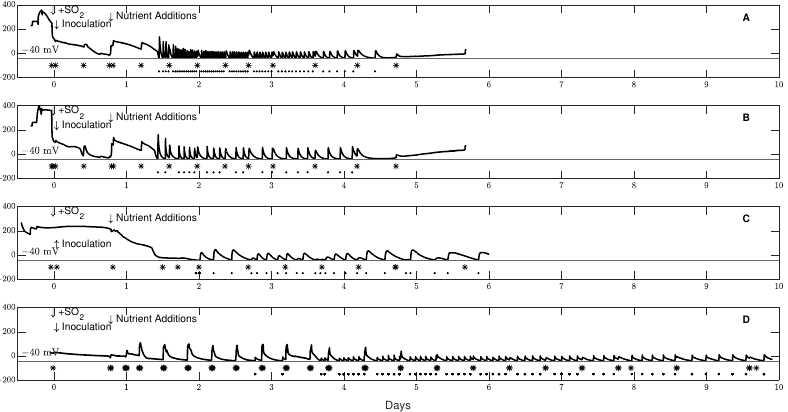
Figure 6. Controlled to –40 mV redox fermentations at scales of 100 L ( A , B ), 1500 L ( C ) and 10,000 L ( D ) with pump-over indicated by (*) and solenoid opening indicated by